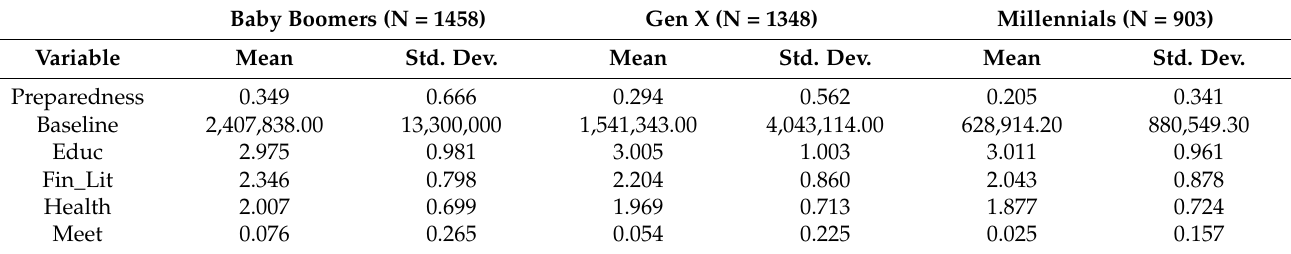
Table A3. Descriptive Comparison by Cohort.